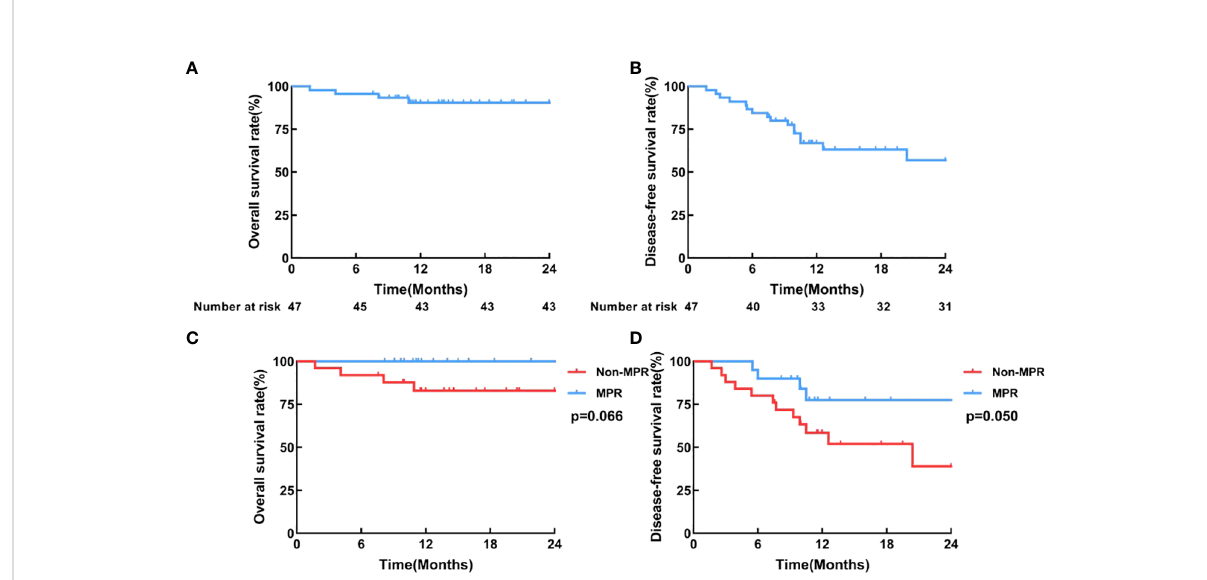
FIGURE 4 Survival curves. (A) Overall survival, (B) Disease-free survival curve of all patients who received surgery (N=45); (C) Overall survival, (D) Disease- free survival curves of the MPR group (n=20) and the non-MPR group (n=25).